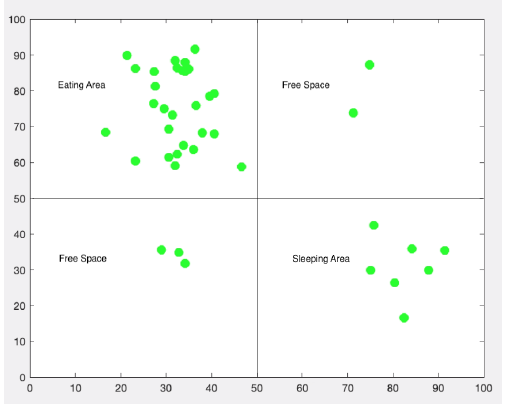
Figure 9. Simulator